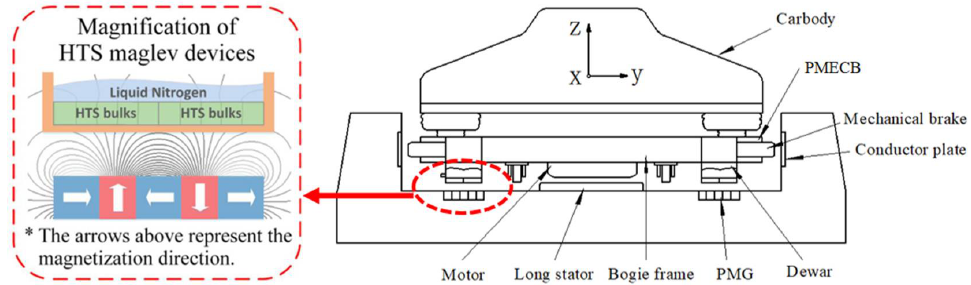
Figure 4. Schematic of principle and layout of the HTS maglev test vehicle system.